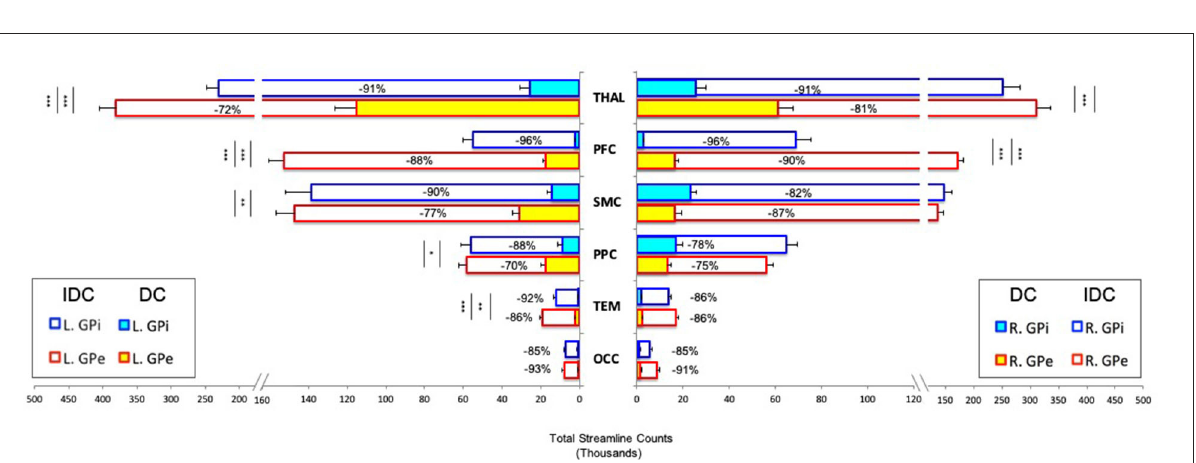
FIGURE3 Pallidocortical and pallidothalamic connectivity strengths as assessed by the group averages of total streamline counts between each seed (GPe/GPi) and target ROI (THAL/PFC/SMC/PPC/TEM/OCC) are plotted. Direct connections (DCs) and indirect and direct connections (IDCs) are overlapped to reflect a percent decrease from IDC to DC. GPe and GPi connections are statistically compared, with significance denoted using inner asterisks to correspond to DC and outer asterisks to IDC. Error bars reflect S.E.M. * p < 0.05, ** p < 0.01, *** p < 0.001. GPe, external globus pallidus; GPi, internal globus pallidus; THAL, thalamus; PFC, prefrontal; SMC, sensorimotor; PPC, posterior parietal; TEM, temporal; OCC, occipital; L, left; R,